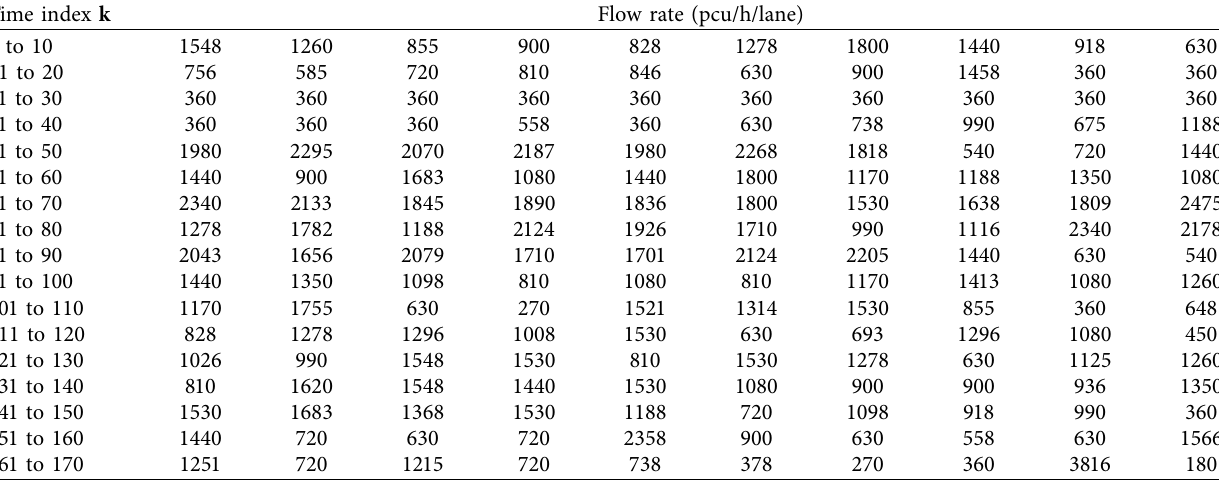
Figure 7: Case study area. Table 1: Traffic volume of main road.